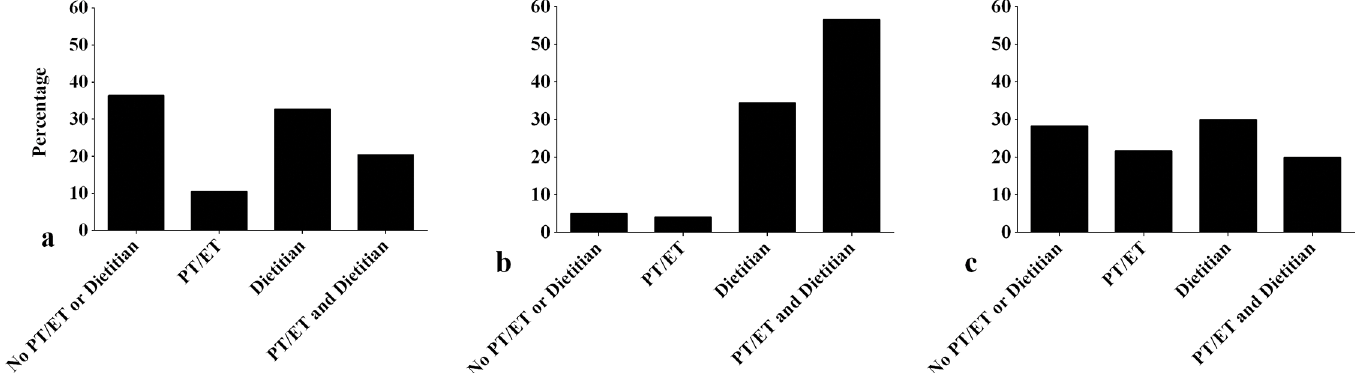
Fig 1. Management of sarcopenia depicted as percentages of consulted healthcare professionals for interventions : (a) before attendance (n = 223); (b) directly after attendance (intention to consult) (n = 223) and (c) five months after attendance (data available in n = 60). PT physiotherapist, ET exercise therapist.